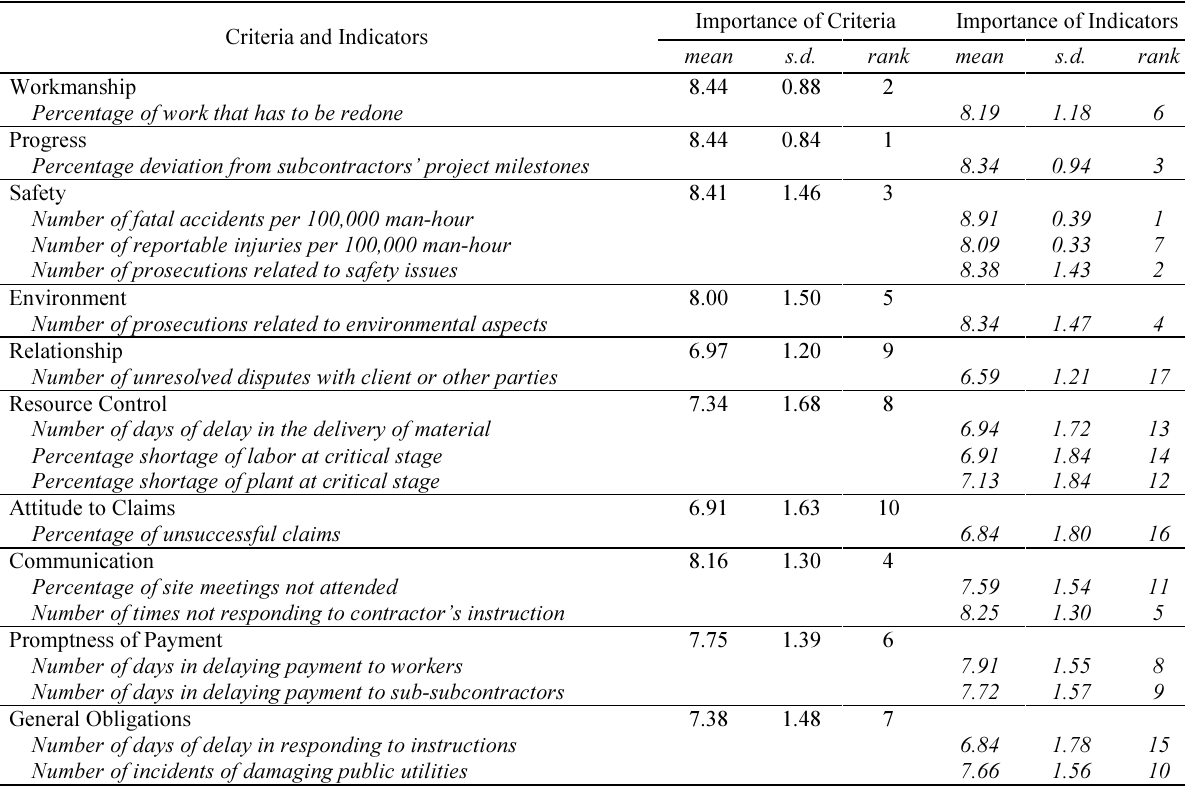
Table 1. Importance of appraisal criteria and quantitative indicators